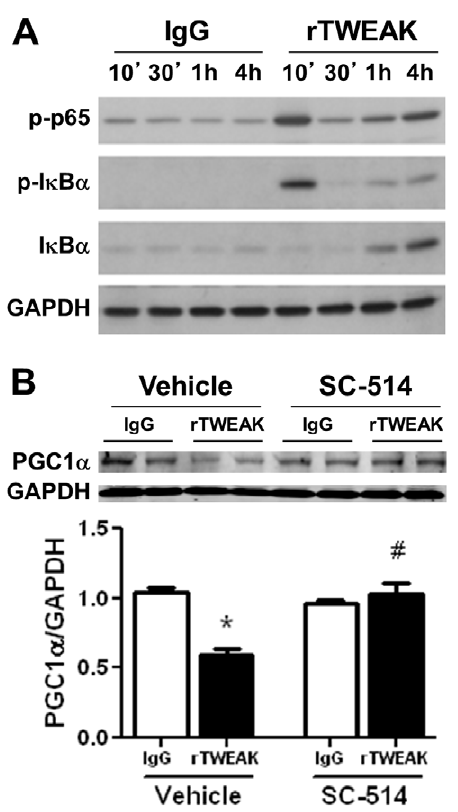
Figure 4. Activation of NF k B mediates TWEAK-induced down- regulation of PGC1 a . (A) Immunoblots of phospho-p65, phospho- I k B a , total-I k B a and GAPDH in isolated cardiomyocytes incubated with 100 ng/ml IgG or rTWEAK at designated time points. (B) Inhibition of NF k B activation with SC-514 (25 m M) abolished TWEAK-mediated downregulation of PGC1 a expression. * p , 0.05 vs. IgG and # p , 0.05 vs. rTWEAK in the absence of SC-514.